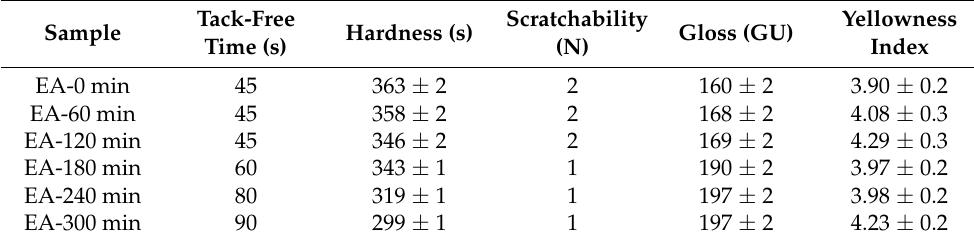
Table 1. The properties of the cured coatings (mercury UV lamp, 280–400 nm, 200 mW/cm 2 ; composition of the photoreactive formulations: 96 wt% of EA prepolymer, 4 wt% of cationic PI).